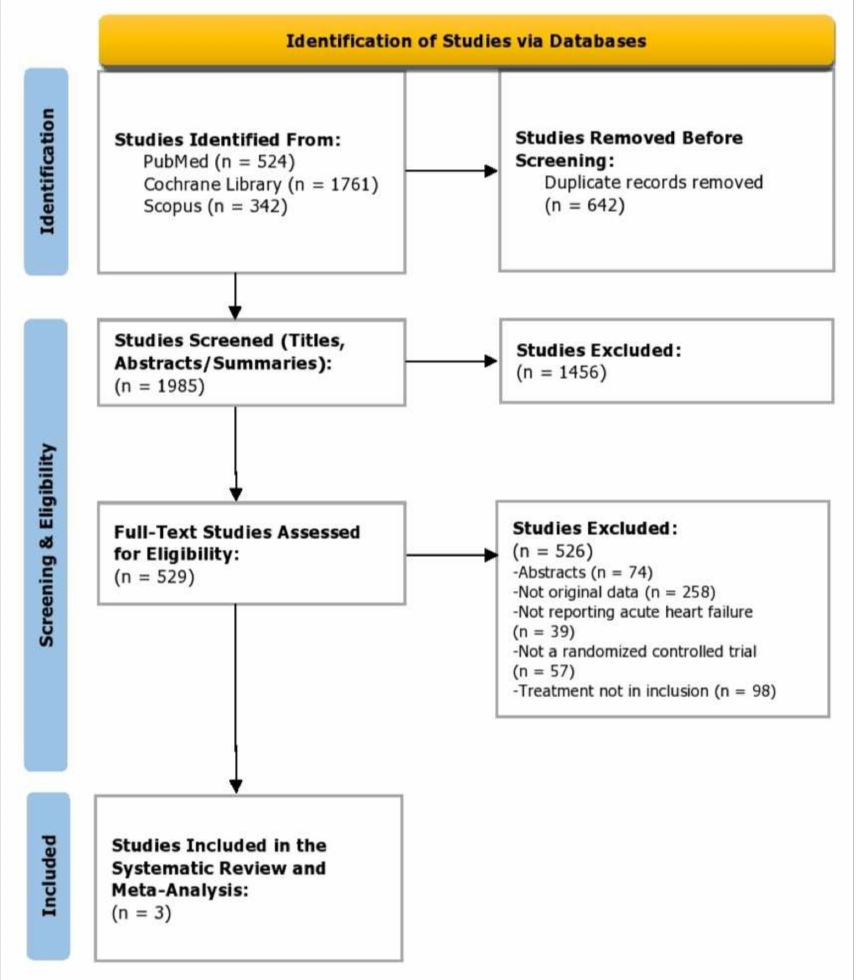
Figure 1. PRISMA flow diagram depicting study